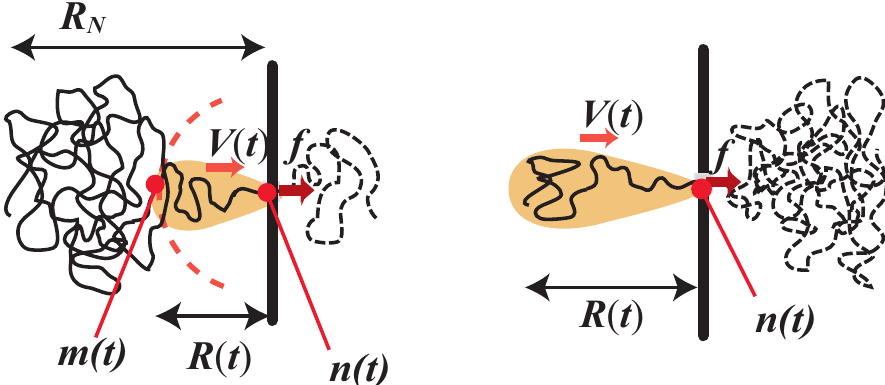
Figure 2. Sketch of a translocating polymer driven by a strong force f . ( left ) Propagation stage: a growing moving domain (with velocity V ( t ) and the size R ( t ) ) on the cis side is shaded, while the chain portion already on the trans side is represented by a dashed curve. ( right ) Post-propagation stage: the tension has already reached to far end of the polymer; thus, m ( t ) = N is constant, and the moving domain is shrinking with time. In addition, most of monomers are already on the trans side, so this post-propagation stage adds a finite-size correction to the scaling formula of the translocation